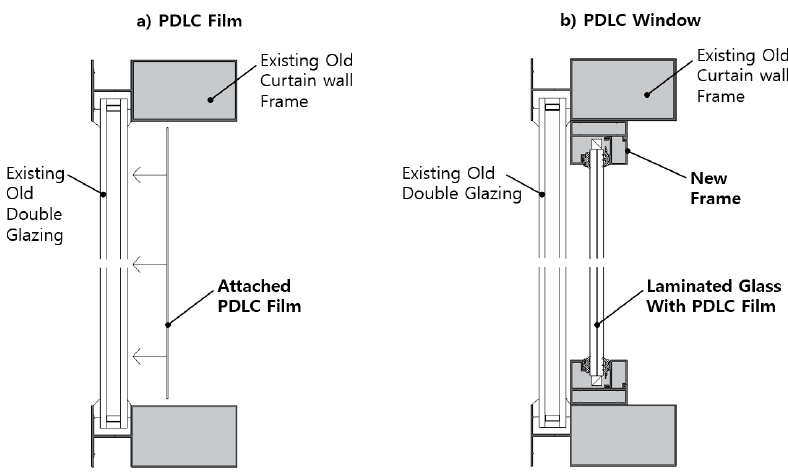
Figure 4. Old window remodeling method using PDLC film.